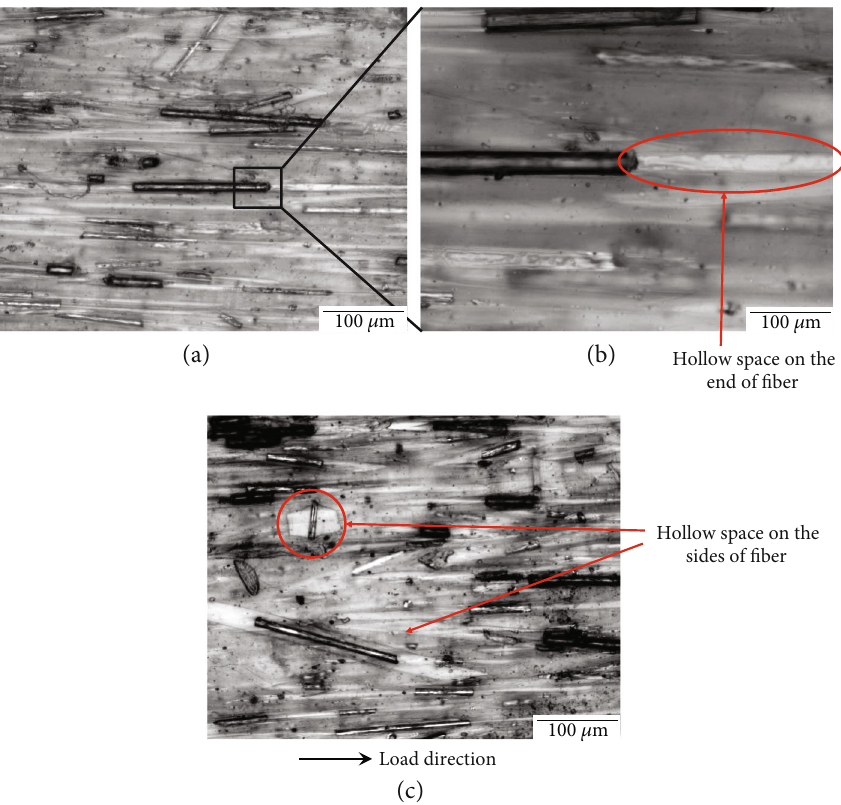
Figure 7: OM images of PP/10SCF composite surface microstructure after the tensile test. (a) SCF perpendicular to the load direction. (b) Image in (a) at higher magni fi cation. (c) SCF misaligned to the load direction.